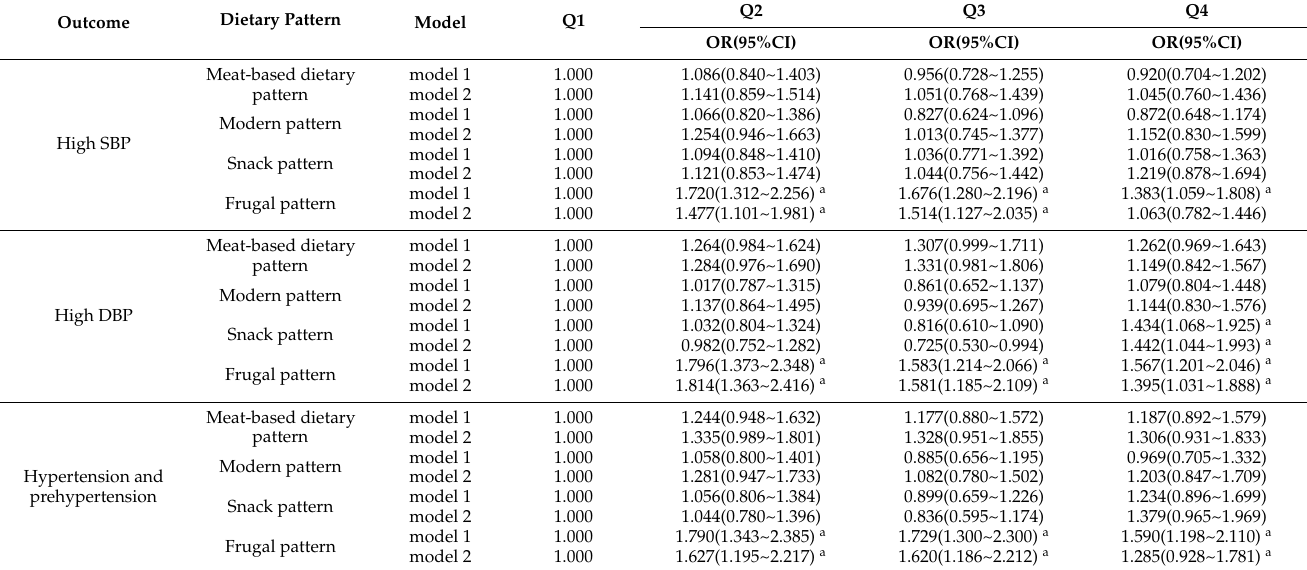
Table 3. The OR of elevated blood pressure across quartiles of dietary